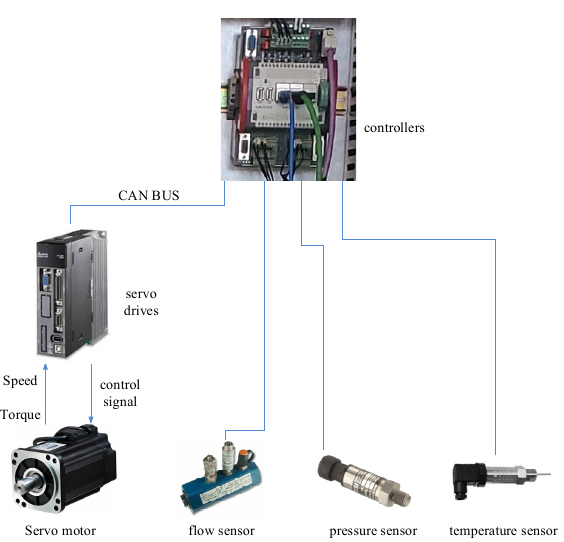
Figure 3. Electric control cabinet.